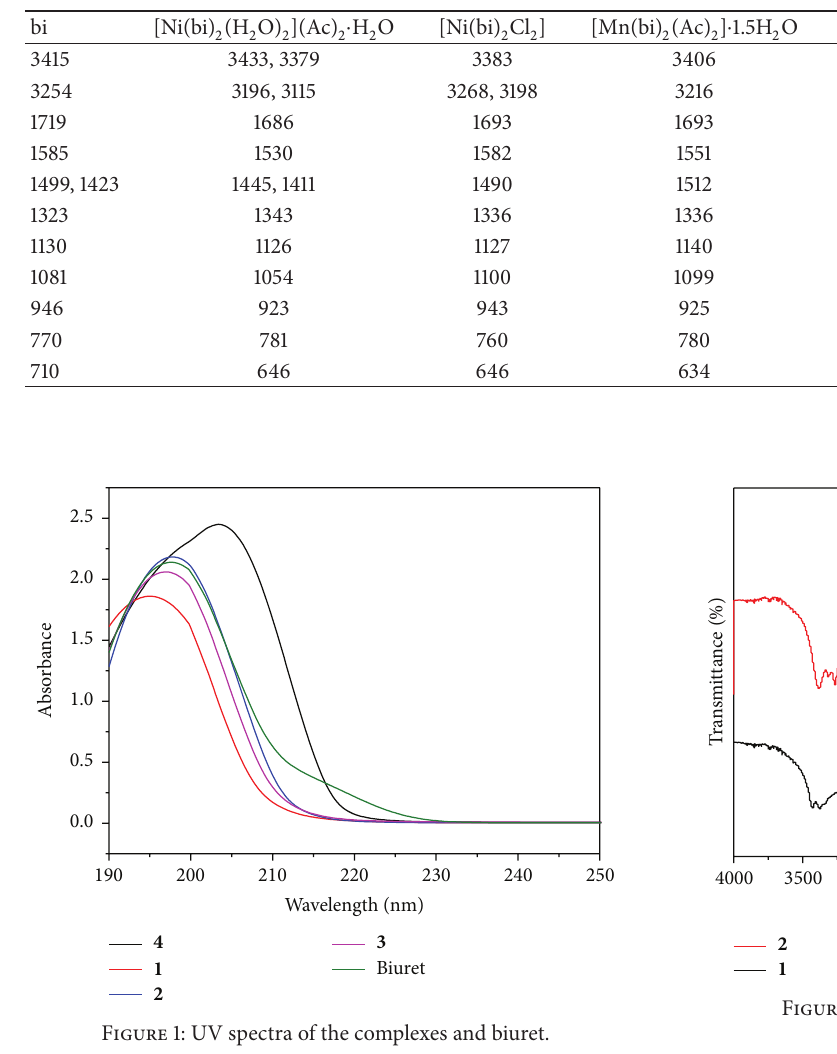
Table 2: Infrared spectra of the ligand and the complexes (cm −1 ).